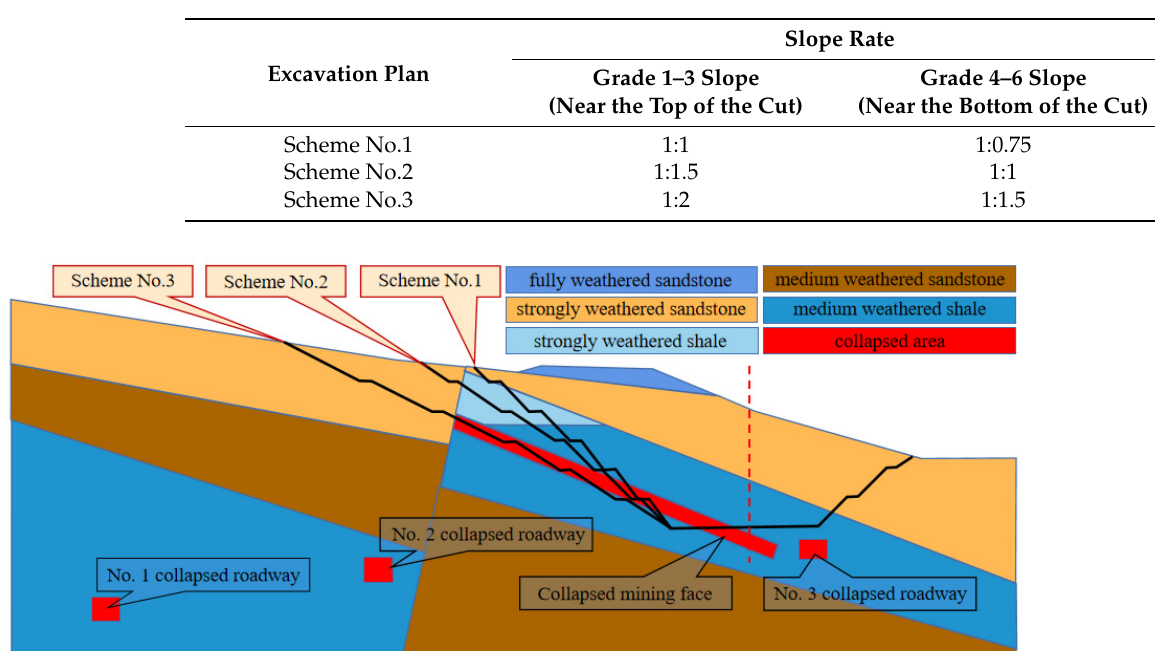
Table 2. The excavation schemes.